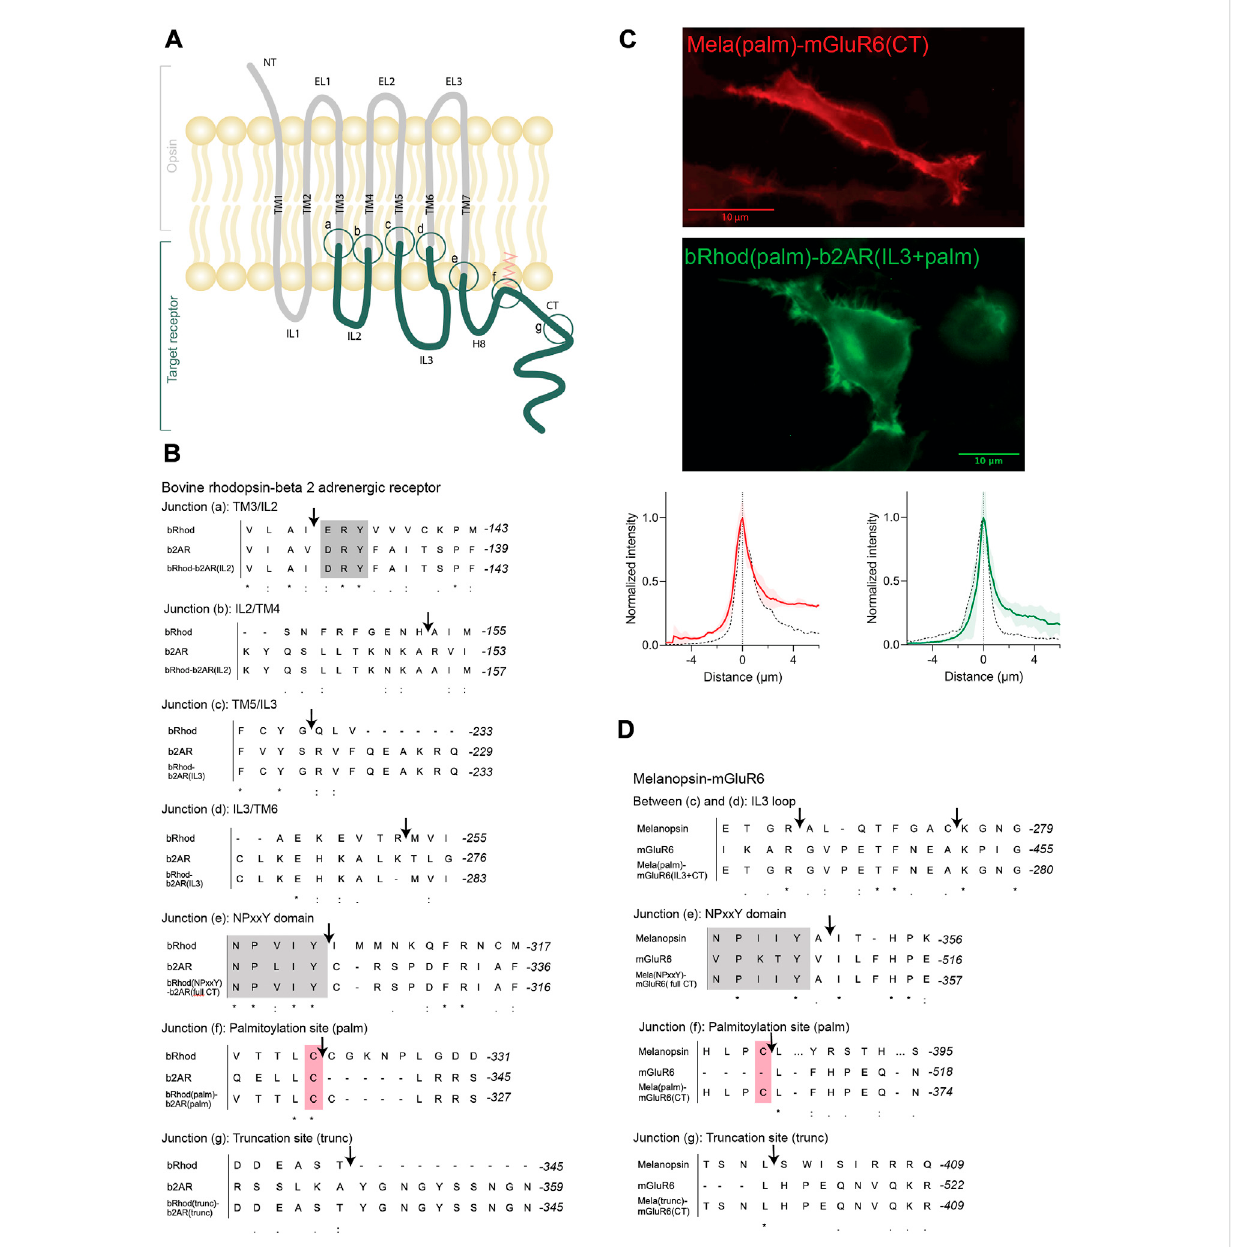
FIGURE 1 OptoGPCR engineering and expression in HEK293 cells. (A) Schematic representation of an Opto-GPCR chimera. The opsin domains are drawn in grey,thedomainsoftheligand-gatedtargetreceptorindarkgreen.SitesA-Ghighlightthechimericrecombinationsites,detailedinpanelsBand (D)(B,D) Sequence alignments of bovine rhodopsin with the beta-2 adrenergic receptor (B) and melanopsin with the mGluR6 receptor (D) around the chimeric fusionsitesshownin (A) .Conservedreferencesitesarehighlightedingrey(NPxxY)andpink(palmitoylatedcysteine). (C) Examplephotomicrographs and cross-sectional expression pro fi les of HEK293 cells expressing Mela(palm)-mGluR6(CT)-mKate2 and bRhod(palm)-b2AR(IL3+CT)-mKate2 fusion proteins, nicely traf fi cked to the cell membrane. The fl uorescence intensity pro fi les are compared to their respective wildtype opsins (black dashed line), which were set to 1. Please refer to Supplementary Figure S4 for all other chimeras and the wildtype